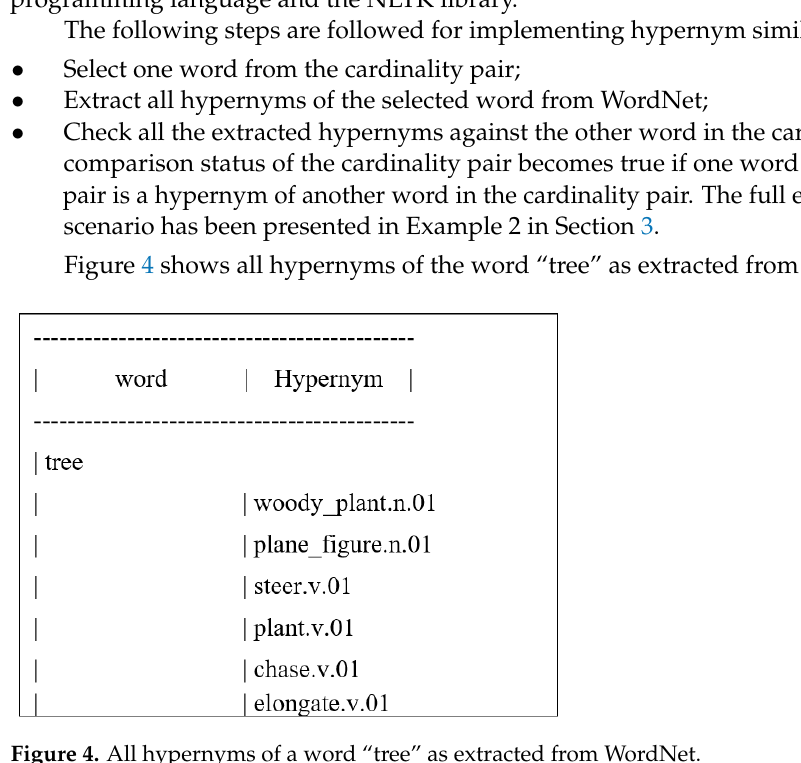
thon programming language and the NLTK library.